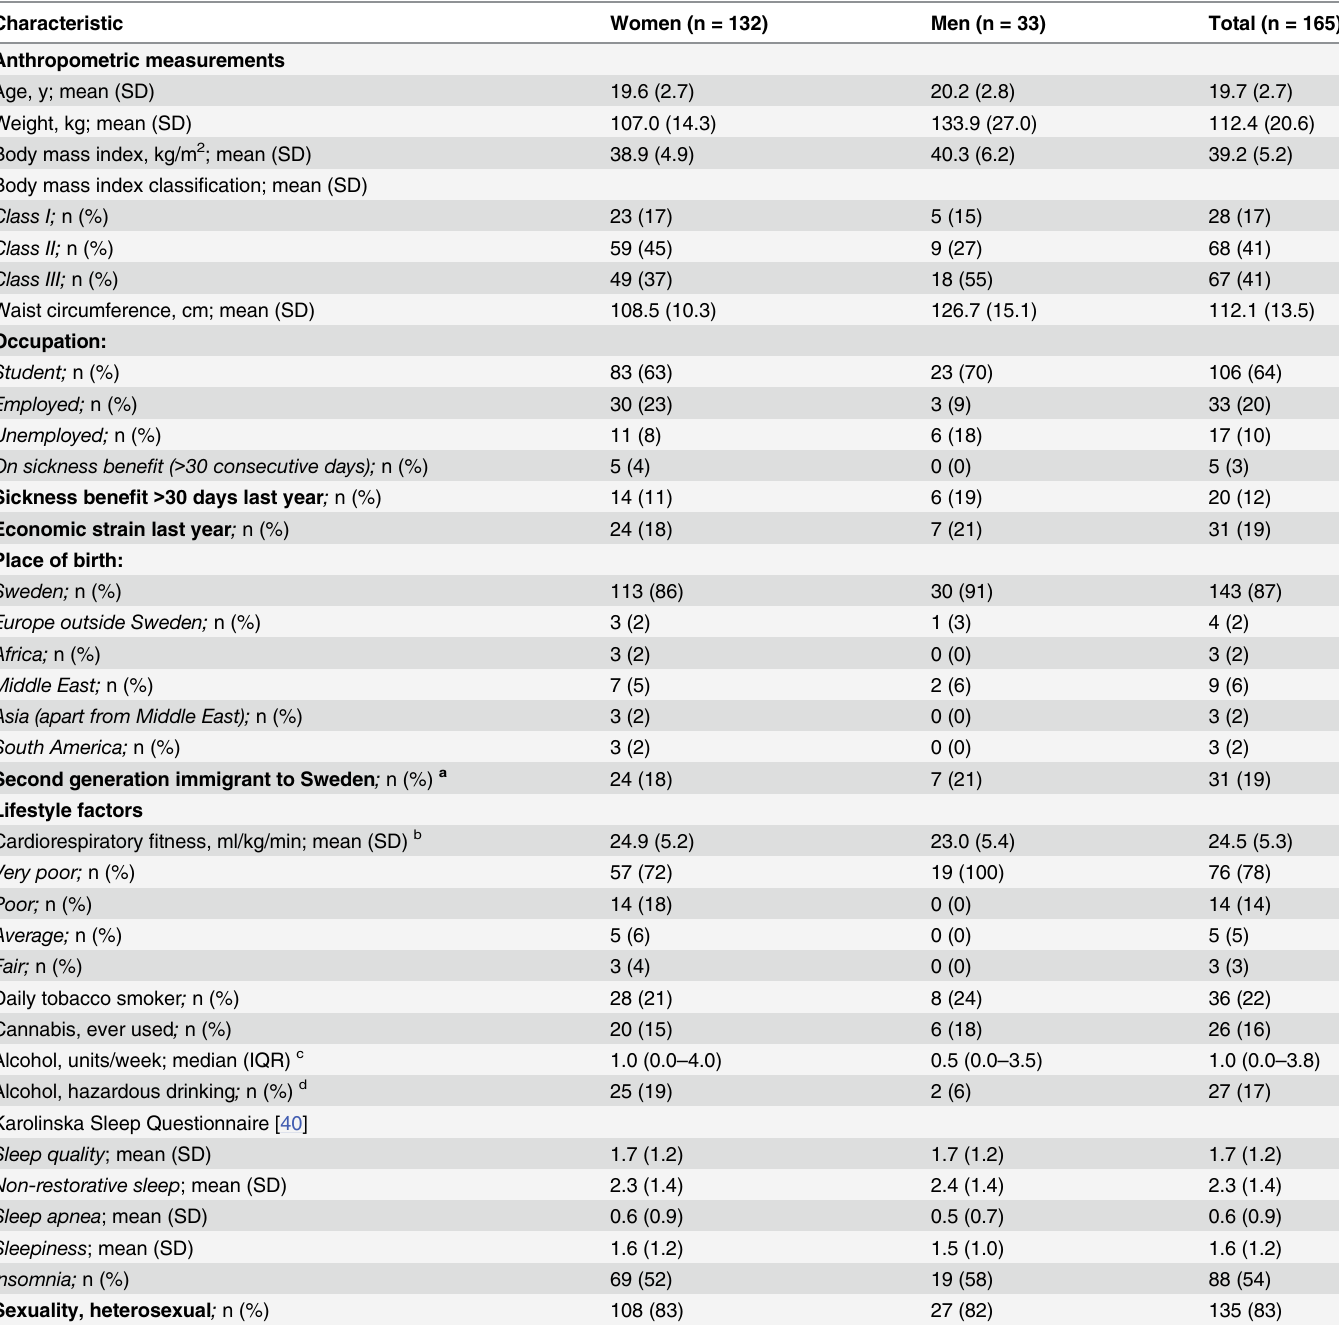
Table 1. Anthropometric, sociodemographic and lifestyle characteristics in n = 165 treatment-seeking young adults (16 – 25 y) with obesity.